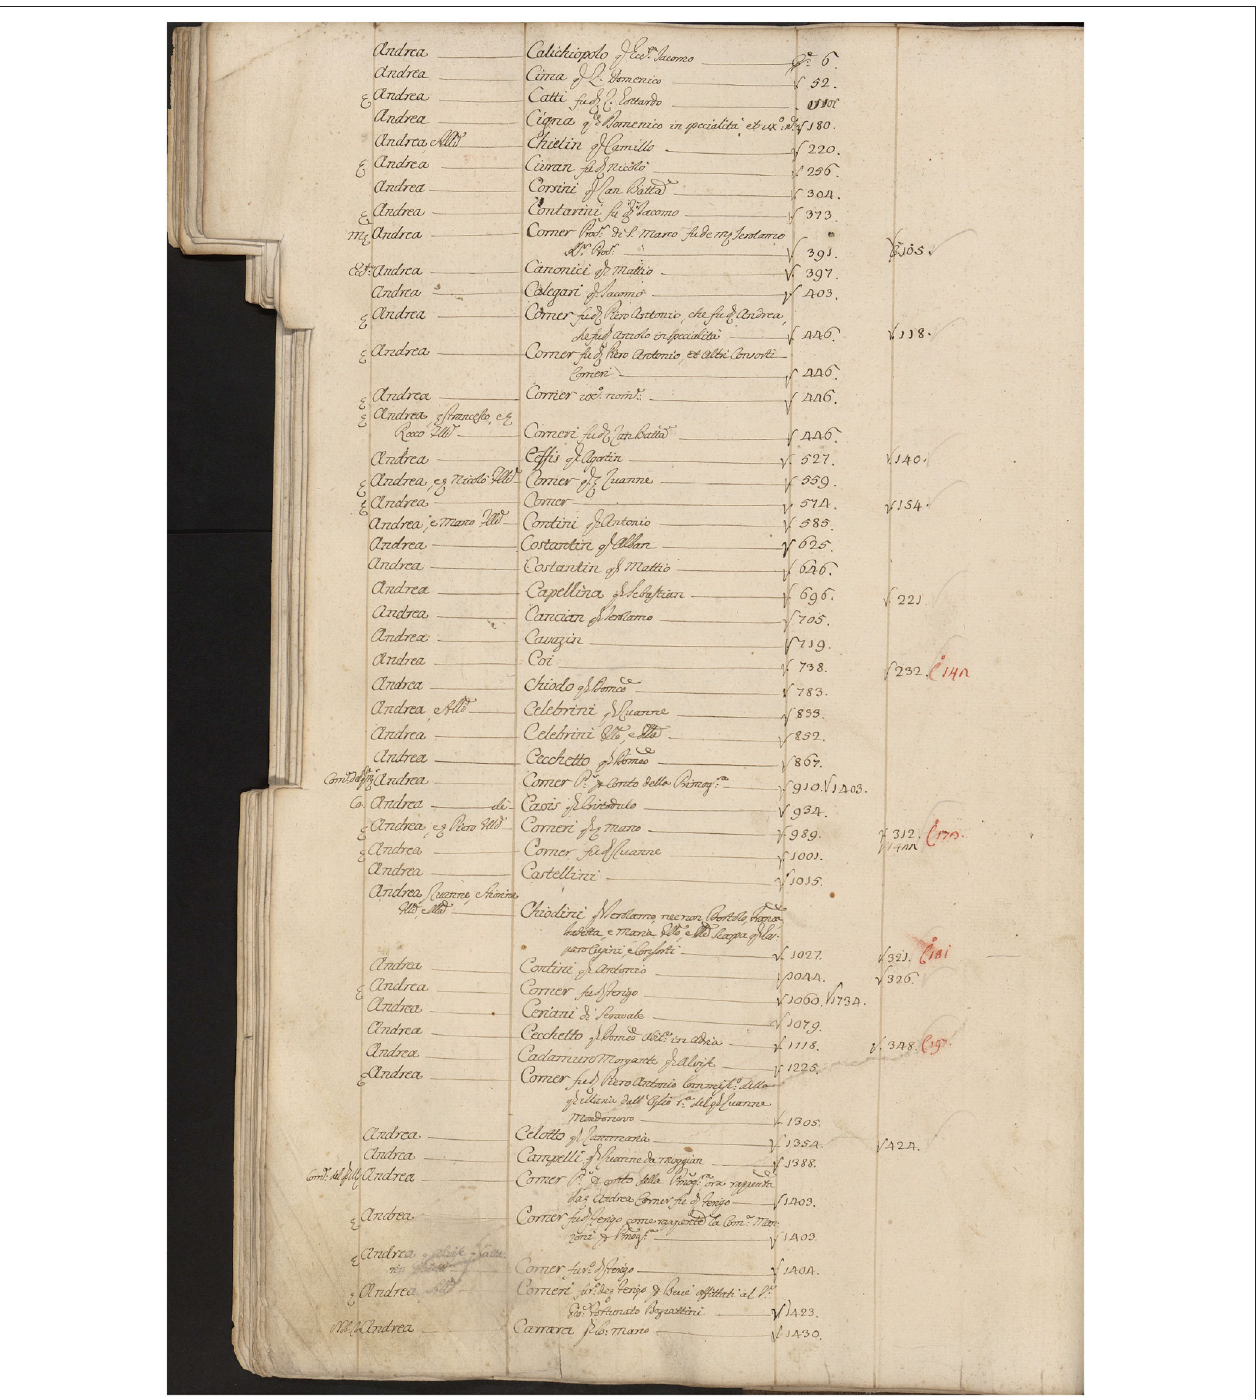
FIGURE 3 | A set of entries in an index of the Quaderni . A row just after the middle, 4th row after the page cut refers to “ser Andrea Corner fu domino Zuanne,” who has one reference, 1001. From: State Archive of Venice, X Savi alle decime in Rialto , Quaderni dei Trasporti , r. 1520, c. 32v.